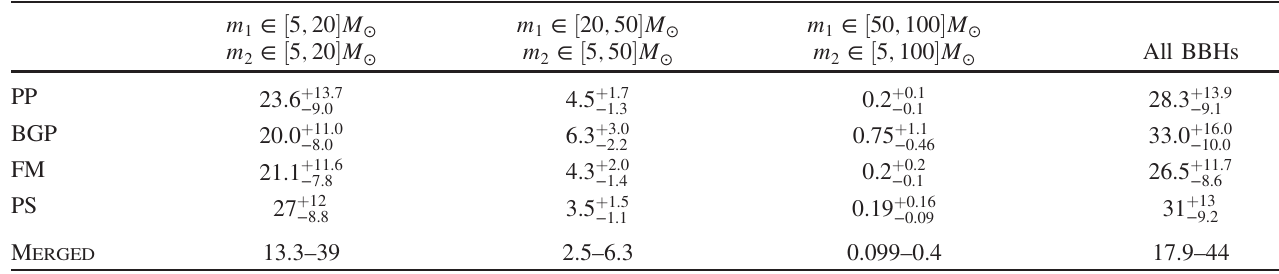
TABLE IV. Merger rates in Gpc − 3 yr − 1 for BBH binaries quoted at the 90% credible interval, for the PP model and for three nonparametric models (B INNED G AUSSIAN PROCESS , F LEXIBLE MIXTURES , P OWER L AW +S PLINE ). Rates are given for three ranges of primary mass m 1 , as well as for the entire BBH population. Despite differences in methods, the results are consistent among the models. BGP assumes a nonevolving merger rate in redshift. The merger rate for PP, FM, and PS is quoted at a redshift value of 0.2, the value where the relative error in merger rate is